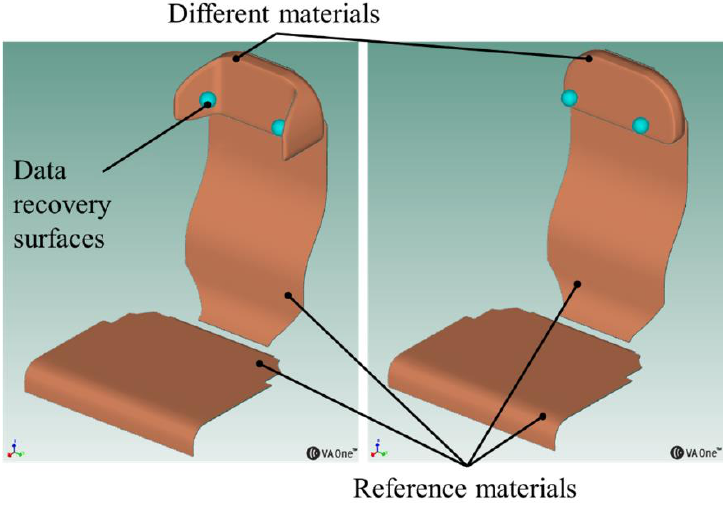
Figure 4. BEM models for the two headrest configurations.